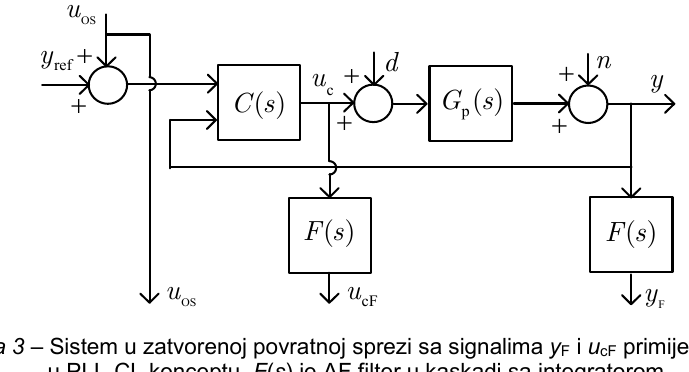
Figure 3 – Closed-loop system with signals y F i u cF applied in the PLL closed-loop (PLL-CL) identification. F ( s ) is the AF filter in the cascade with the